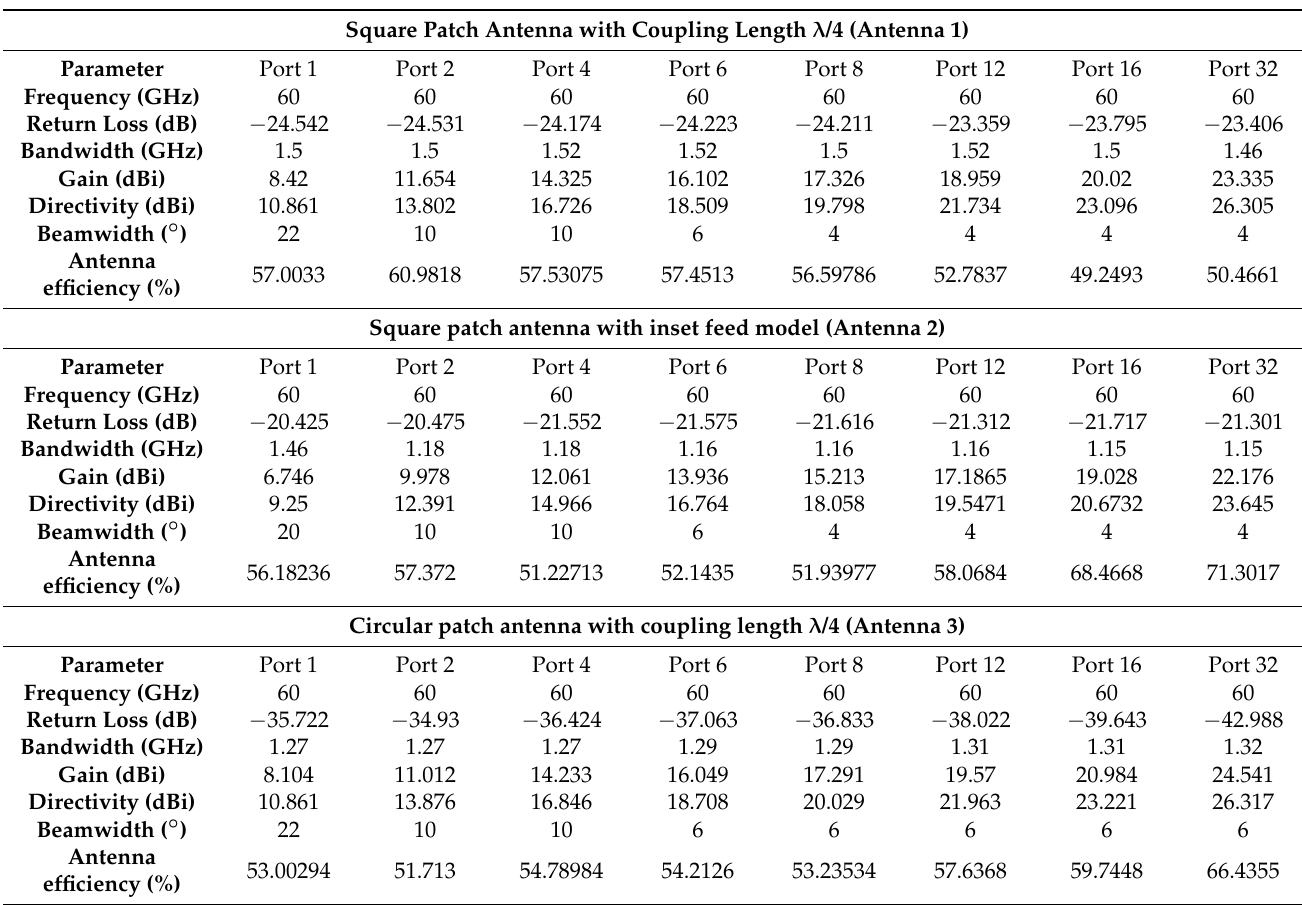
Table 4. Estimated data for the development of